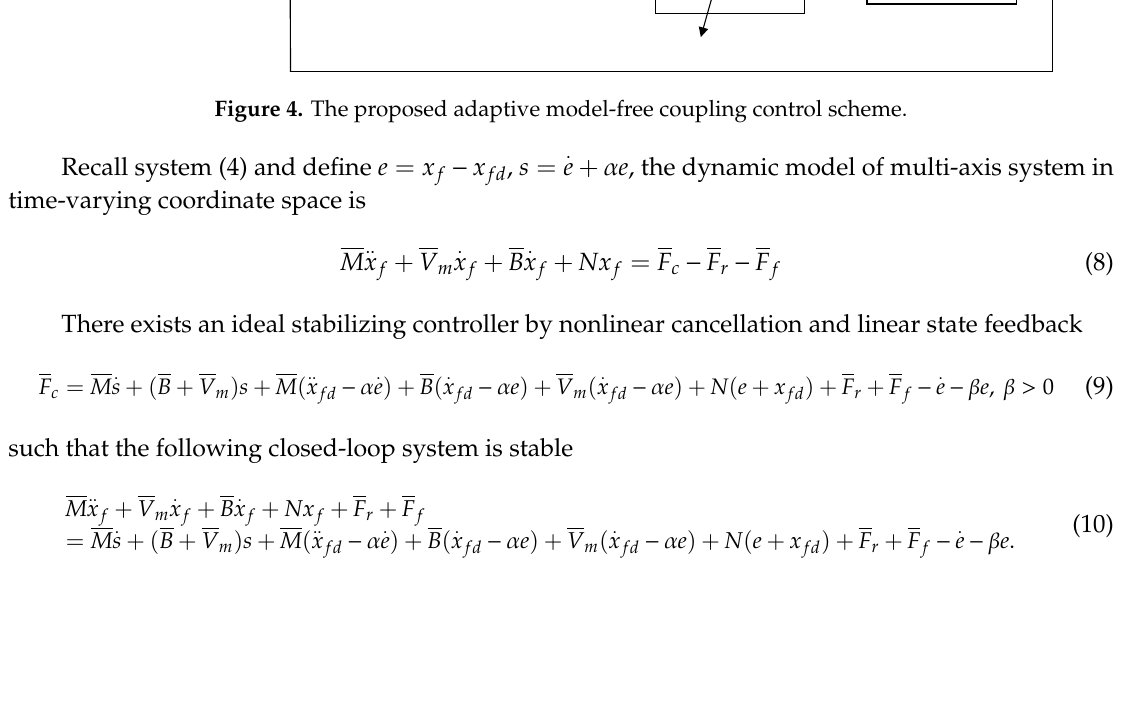
Figure 4. The proposed adaptive model-free coupling control scheme.